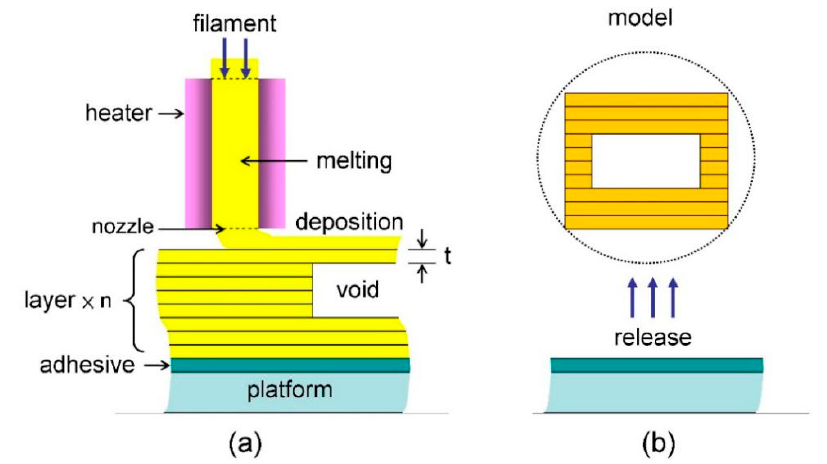
Figure 2. Schematic of the three-dimensional (3D) printing process based on the filament deposition modeling (FDM) method: ( a ) The multilayer grid structure formed with a single layer thickness t featuring the inside voids such as channels and pores; ( b ) direct release of the 3D printed model from the underlying platform.